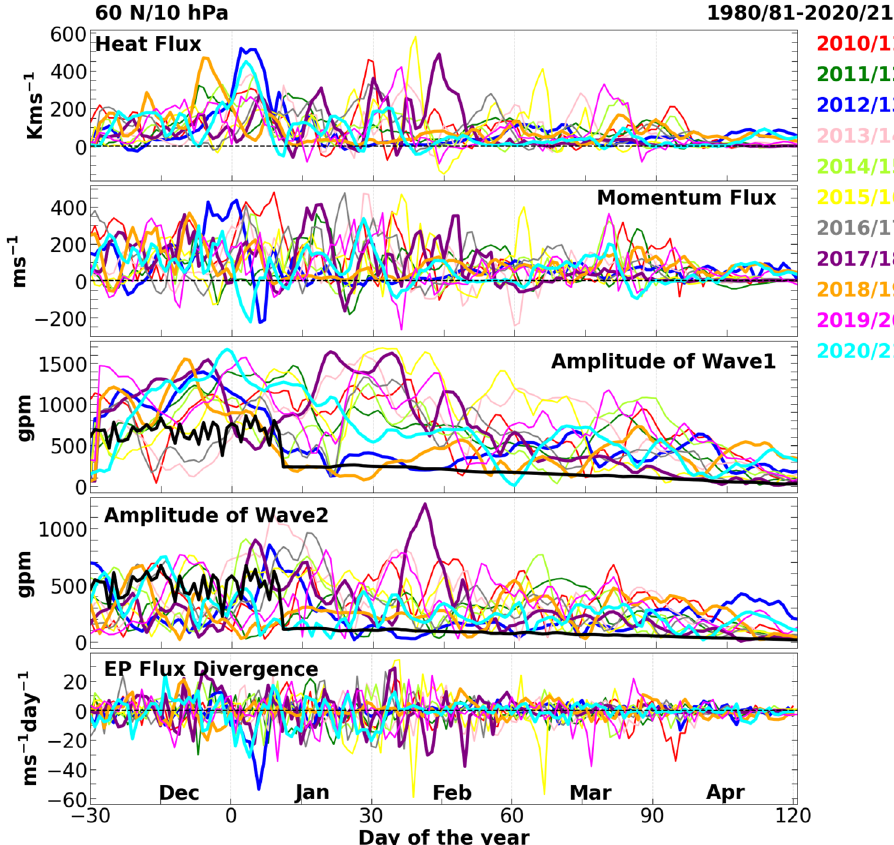
Fig. 5 Temporal evolution of meteorological parameters for the Arctic winters 2010/11– 2019/20. The values are shown corresponding to 60° N lati- tude and 10 hPa. The dashed horizontal line indicates zero magnitude and the vertical lines indicate the separation by months. The climatology for the amplitudes of wave 1 and wave 2 is shown in the black line in the third and fourth